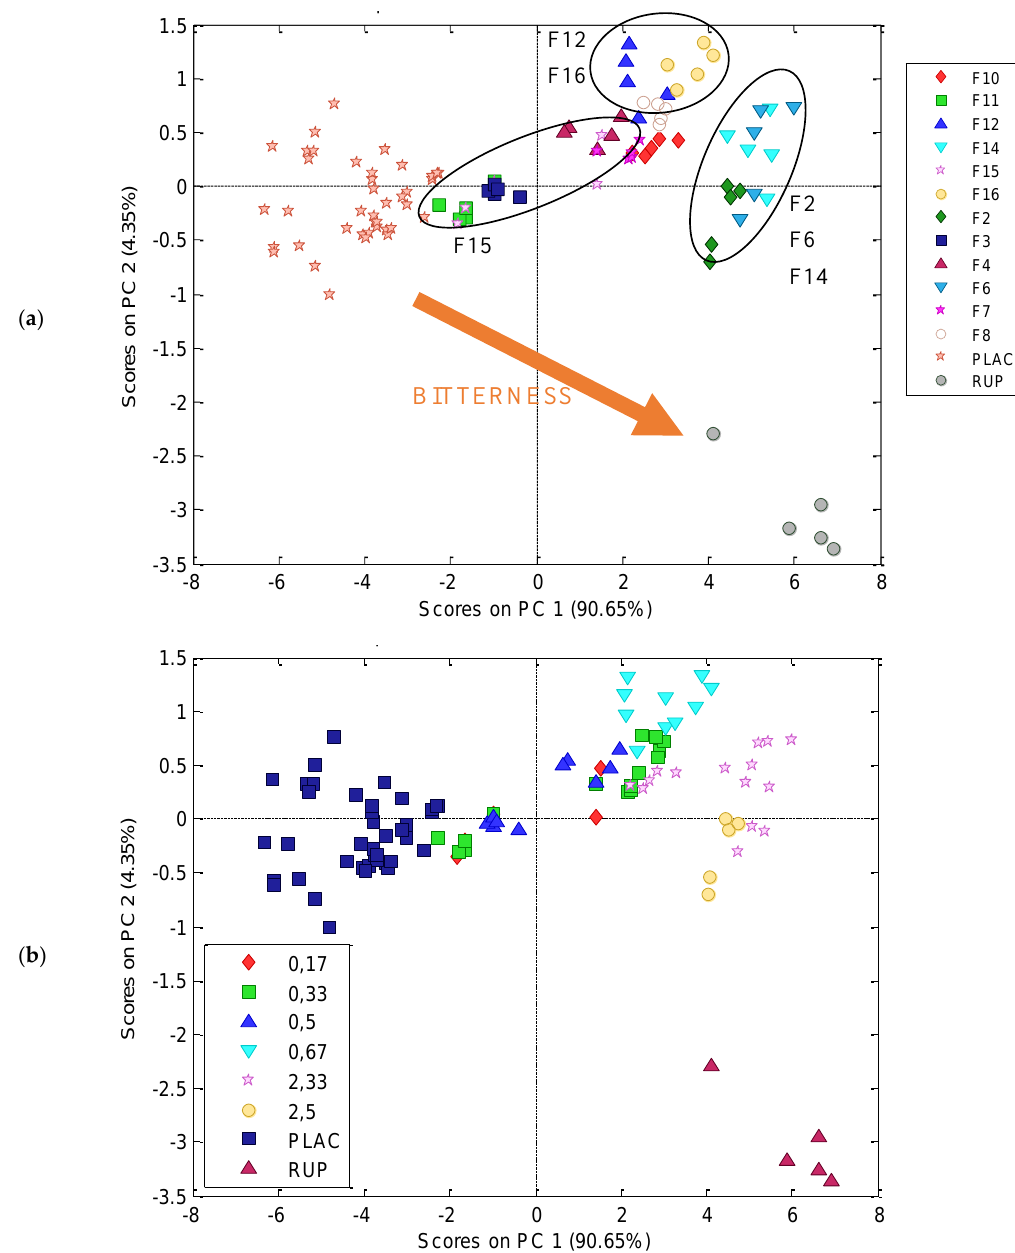
Figure 8. PC3, PCA score plot of electronic tongue responses for all studied formulations (F2-F16), respective placebos (PLAC) and pure RUP. On both plots the same object are presented, therefore they are in the same configuration, but the symbols are given according to: ( a ) formulation type; ( b ) mean values of bitterness score calculated from Table 5.